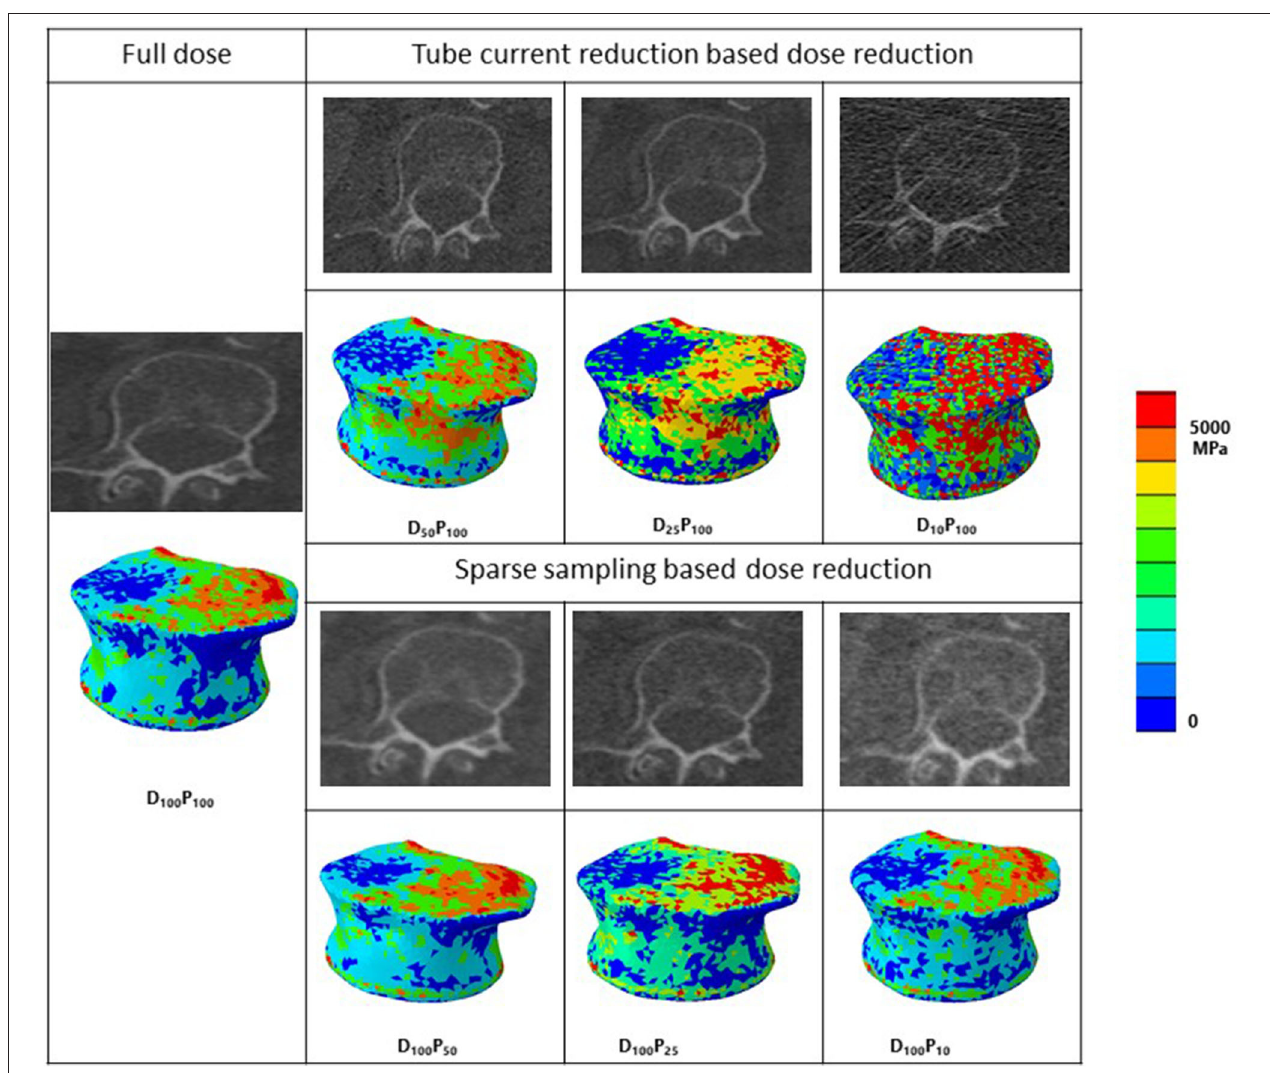
FIGURE 2 | MDCT radiological images along with corresponding representative 3-D contour plots of Young’s modulus distribution along the axial direction after material mapping at different dose levels in the vertebra. Red color region shows the maximum, whereas blue color region shows the minimum Young’s modulus values in the bone. D, tube current reduction–based dose reduction; P, Sparse sampling–based dose reduction.